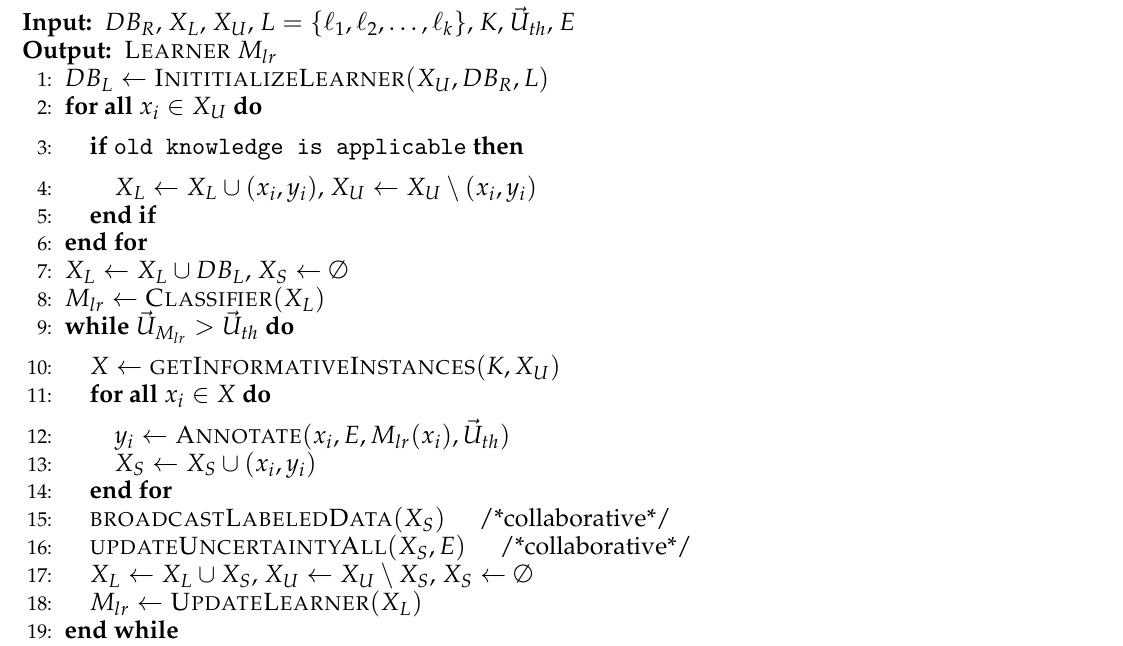
Algorithm 1 C OLLABORATIVE A CTIVE L EARNING -D